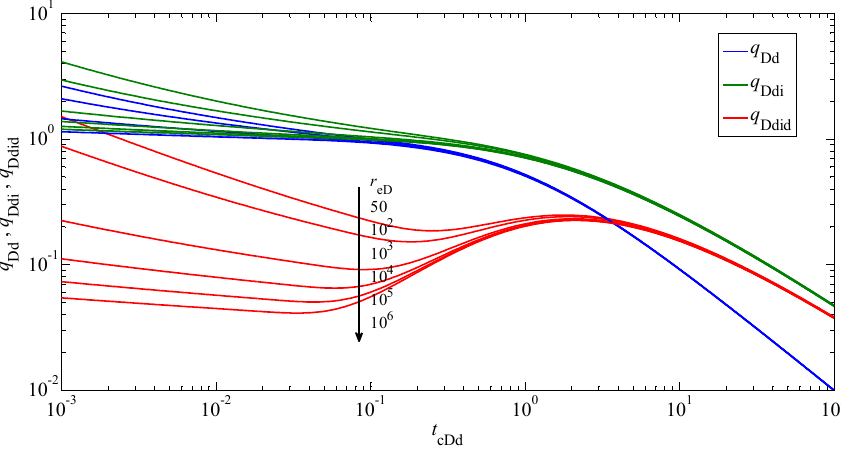
Figure 3. Blasingame type curves of vertical wells.